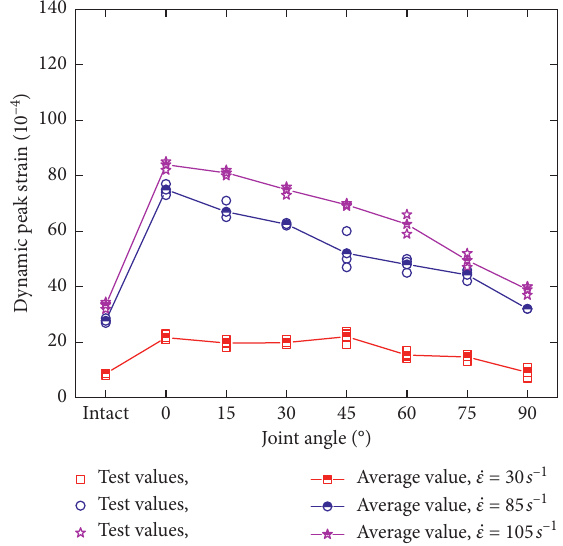
Figure 6: Relationship between dynamic peak strain and joint angle under three different strain